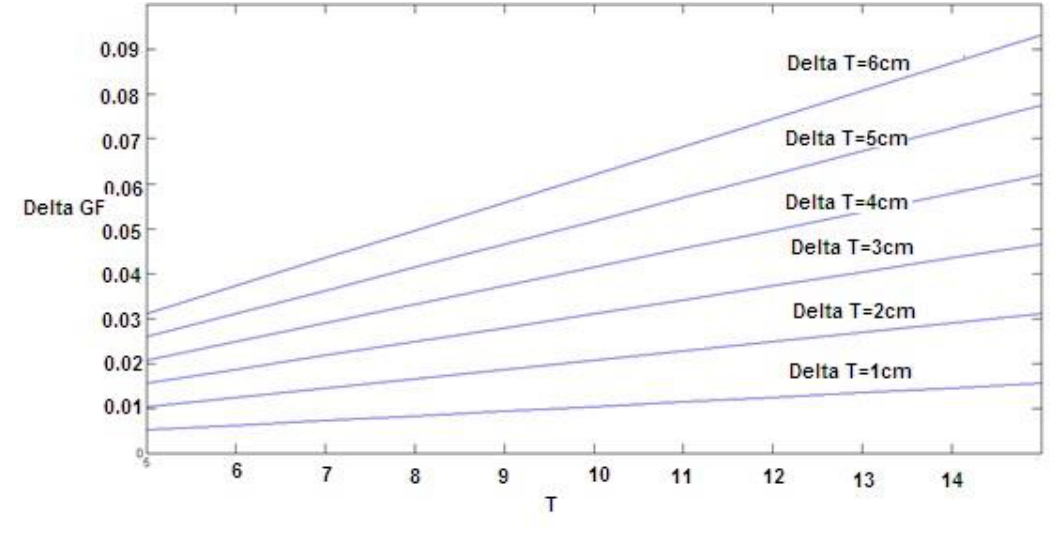
Figure 8. The effect of width change on fracture energy.